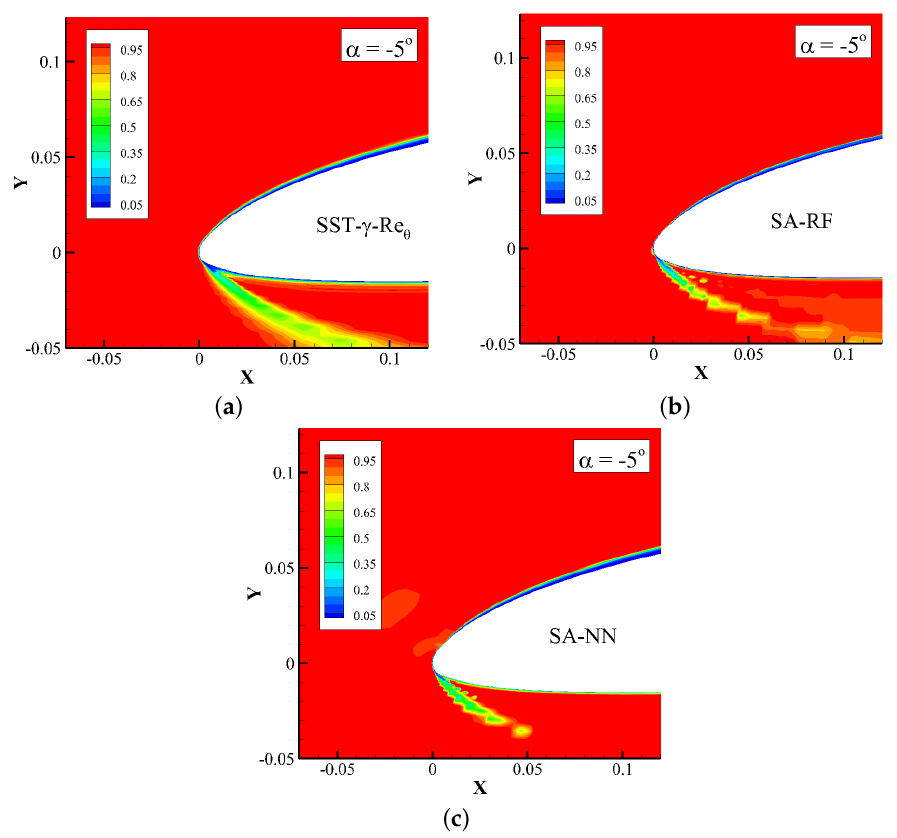
Figure 15. Intermittency distribution of E387 airfoil under an angel of attack of − 5 ◦ . ( a ) SST- γ − Re θ .